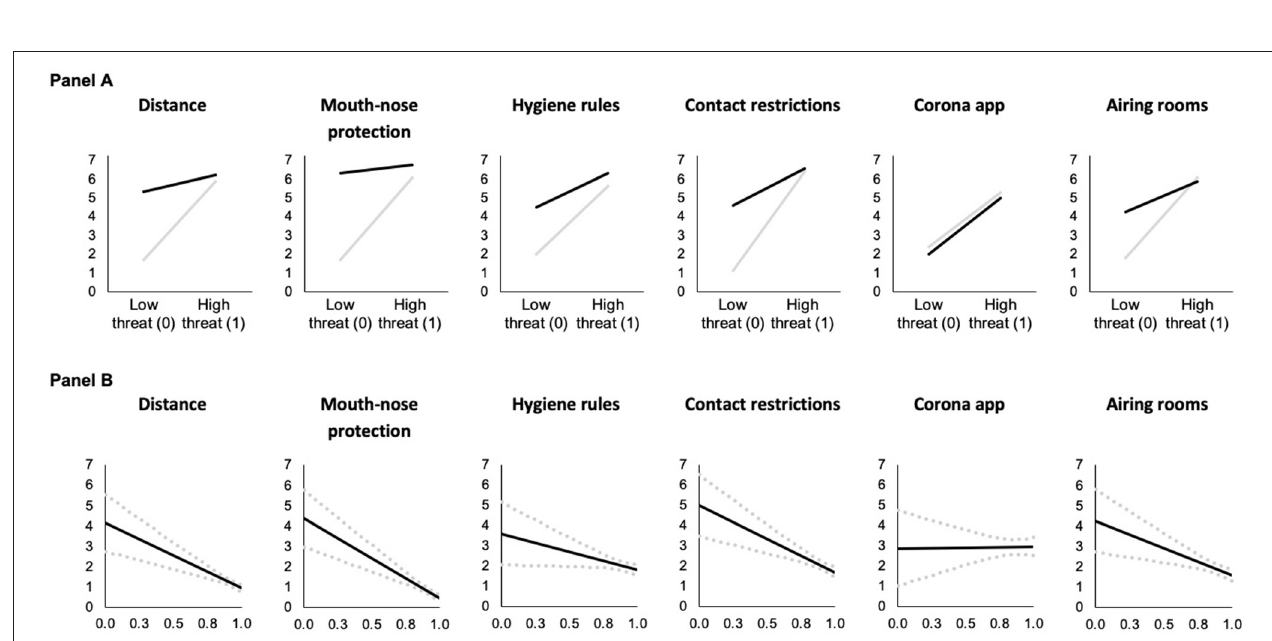
FIGURE 4 | Predicted adherence as a function of COVID-19 threat at different levels of knowledge about COVID-19 (A) and conditional effect of COVID-19 threat as a function of knowledge about COVID-19 in the risk of exposure models (B) (based on Models 3 and 8 in Tables 4 , 5 , N = 4,096). In (A) , gray lines ( — ) indicate low knowledge (0) and black lines ( — ) indicate high knowledge (1). Predictions are for men who are 18 years and at risk of exposure. In (B) , the black solid lines ( — ) indicate the conditional effect perceived COVID-19 threat from the lowest (0) to the highest (1) level of knowledge about COVID-19 and dotted gray lines ( • • • ) indicate the upper and lower 95% confidence interval; and all Johnson-Neyman values are statistically significant ( p < 0.05).